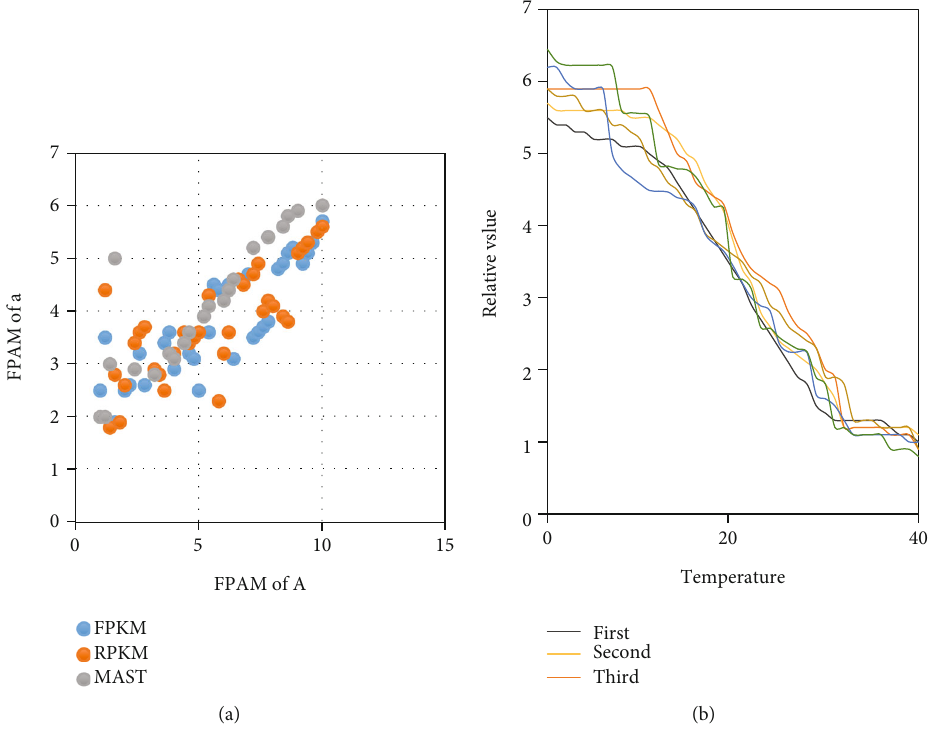
Figure 10: Ampli fi cation curve and dissolution curve of β -actin